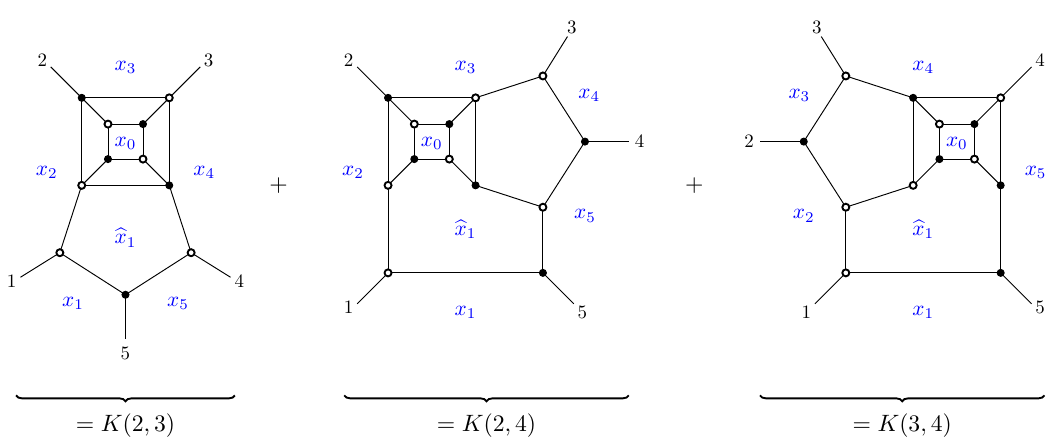
Figure 5 . Five-particle amplitude A (1) = K (2 ; 3) + K (2 ; 4) + K (3 ; 4) from the momentum twistor 5 recursion. The (cid:12)rst term comes from tree-level factorisation, and the other terms come from the forward